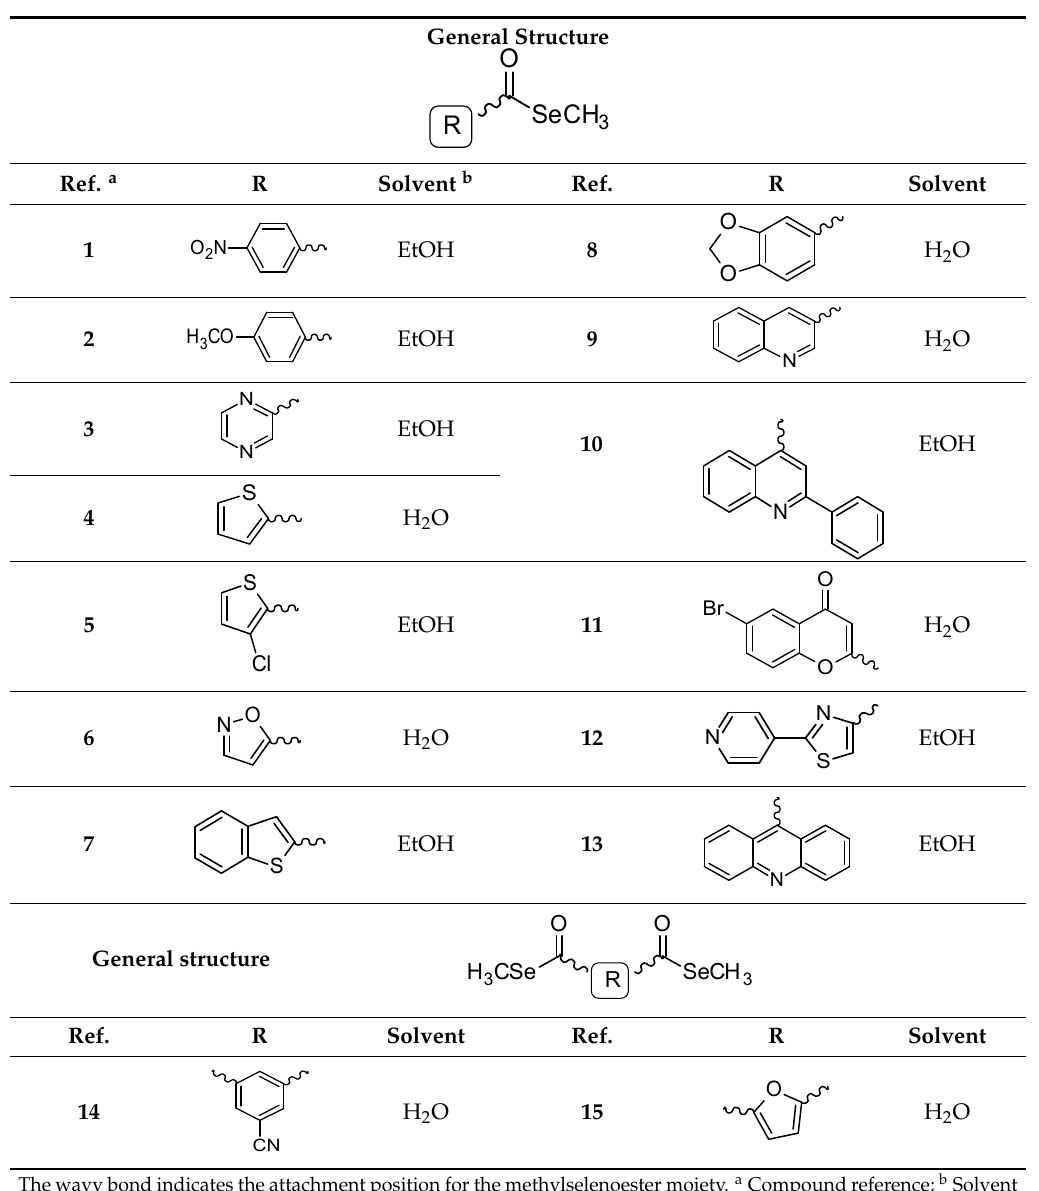
Table 1. Structure of the novel synthesized methylselenoesters.